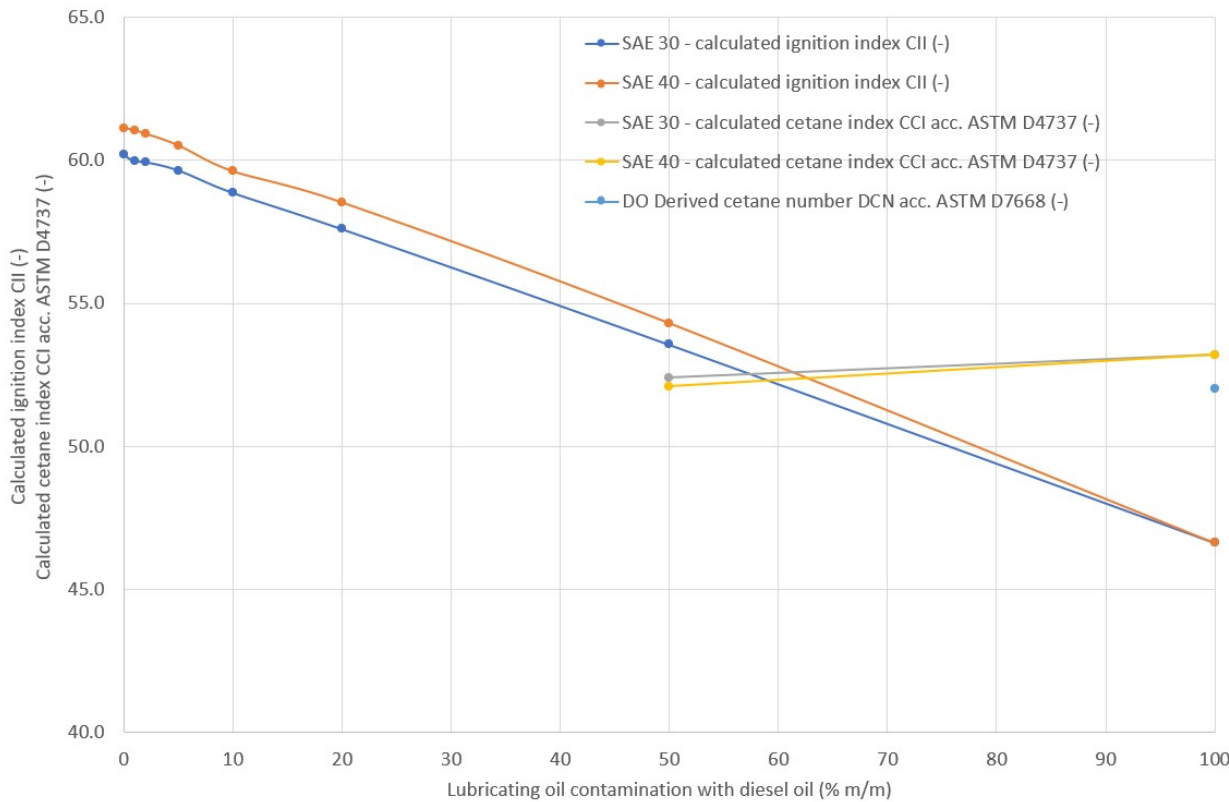
Figure 23. Ignition and cetane indices of tested lubricating oils at different levels of lubricating oil dilution with diesel fuel.